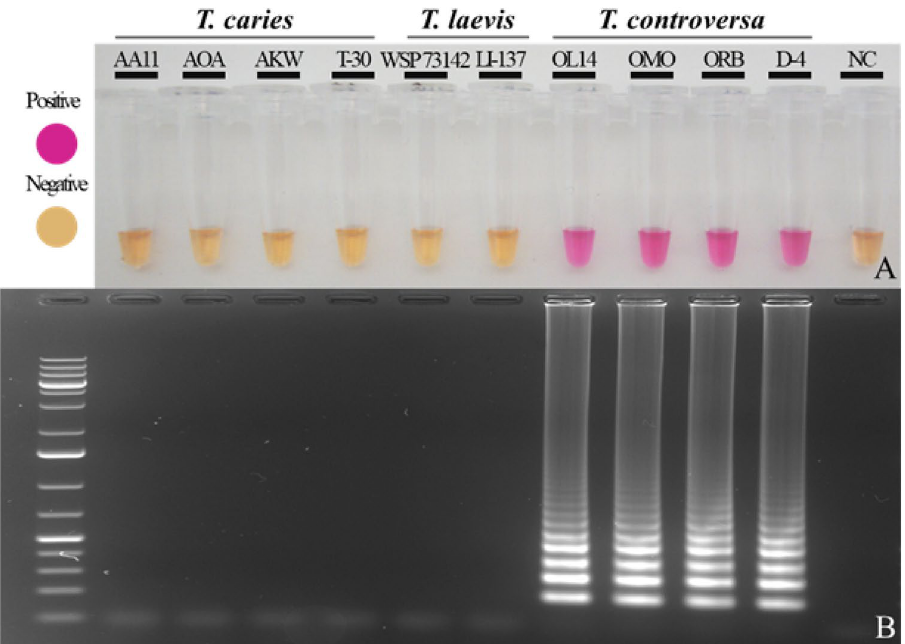
Figure 4. End-point detection of T. controversa using neutral red. The LAMP assay was performed at 65 °C for 45 min. ( A ) Colorimetric detection under daylight conditions. Positive reactions appear in pink while negative reactions are light orange. NC is a water control. ( B ) The same reactions separated on a 2% agarose gel and visualized using SYBR safe. A positive LAMP reaction is represented by a ladder-like fragments pattern. NC is the water control and Ladder is 1 kb Plus DNA size marker. The assay detects only T. controversa